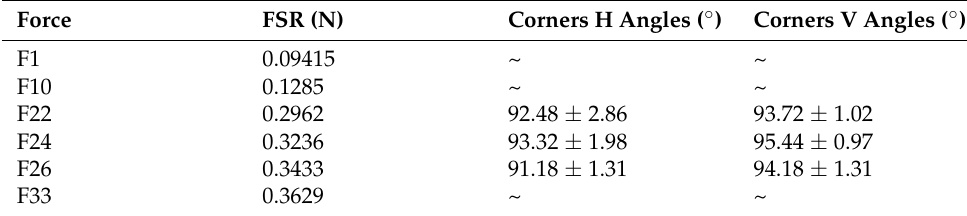
Table 1. Characterization of Forces for Cutting